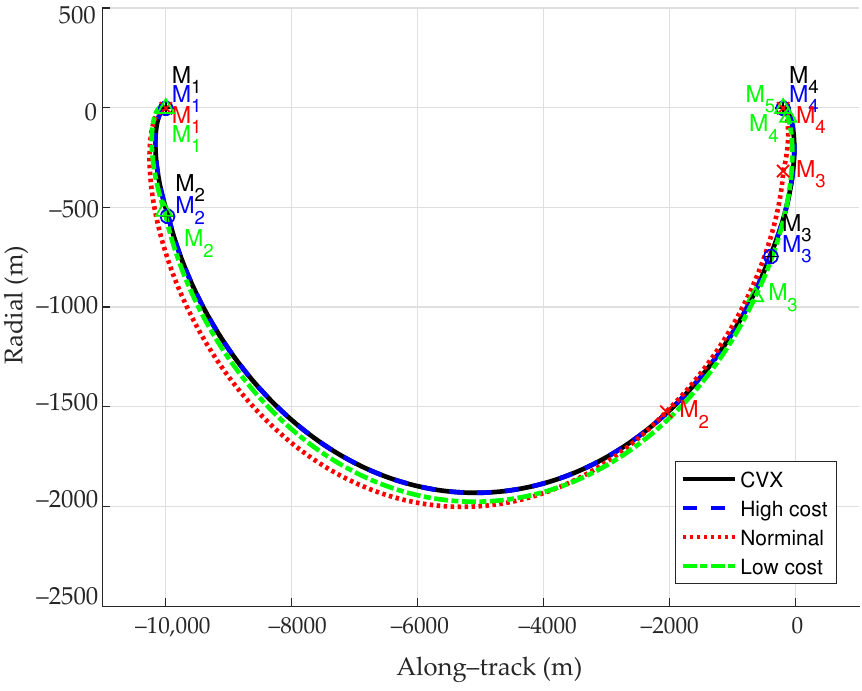
Figure 6. Optimal trajectories (in-plane) when t f = 6000 s.